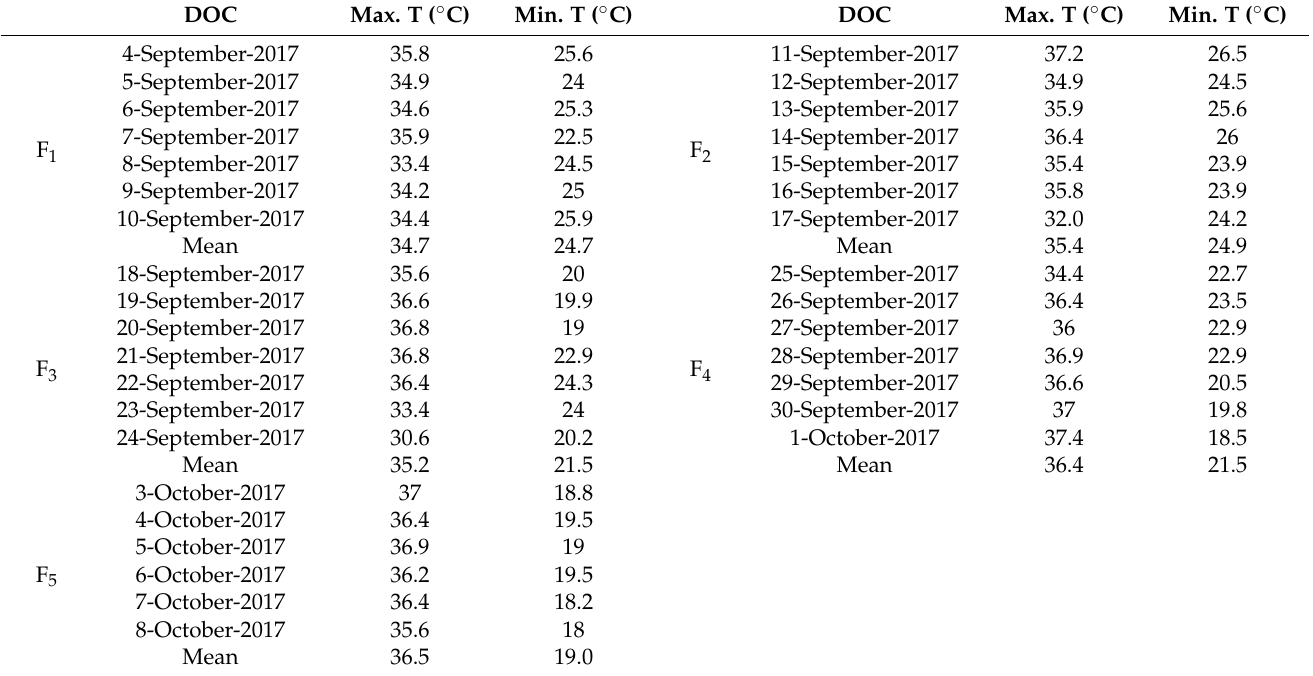
Table 2. Temperature conditions under different crossing periods of bottle gourd during the field